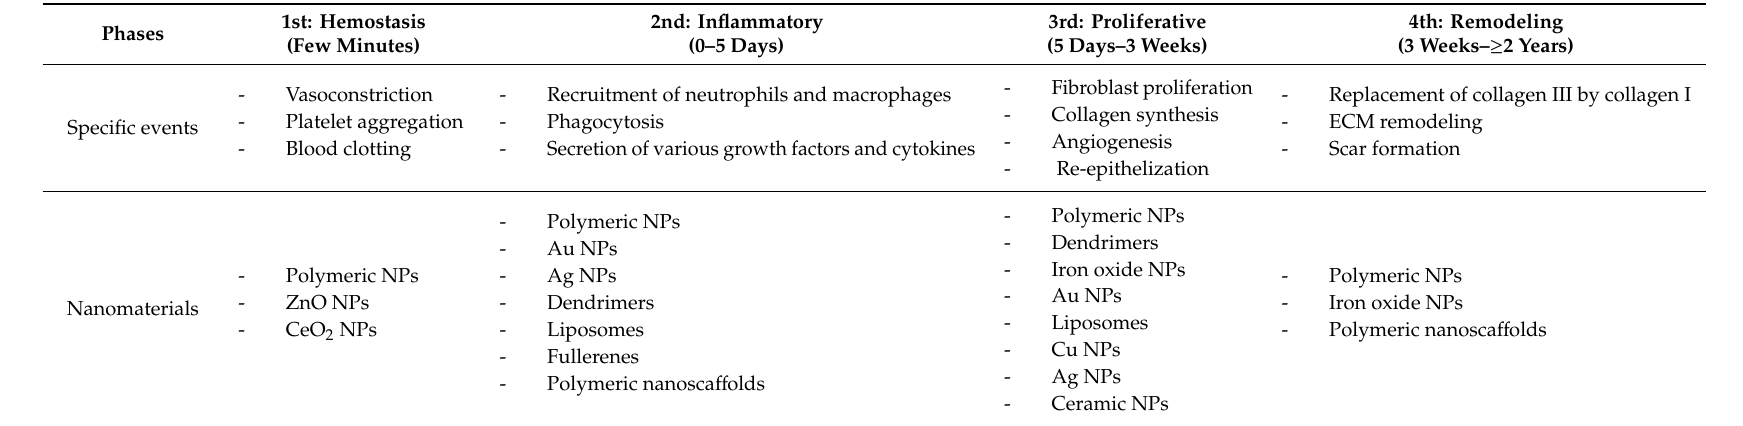
Table 1. Nanomaterials that showed favorable e ff ects in di ff erent wound-healing